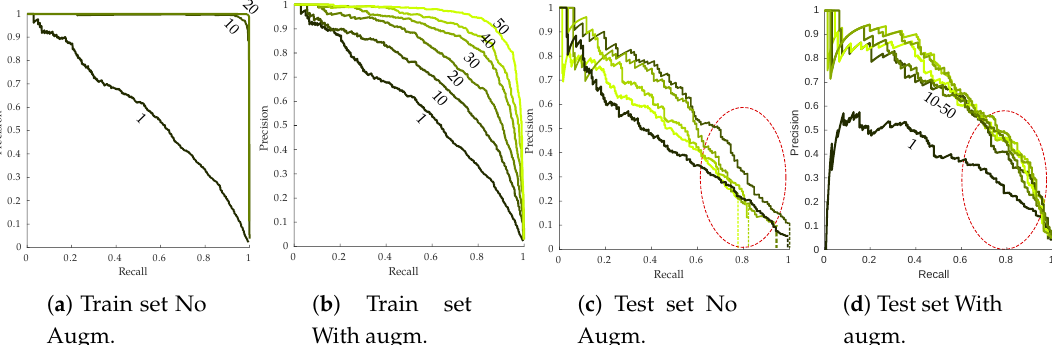
Figure 14. Effect of the data augmentation parameter on training ( a , b ) and testing ( c , d ) esca RP curves. Epochs 1/10/20/30/40/50 are plotted. Dark green curves: early epochs; light green curves, late epochs. Vertical dotted lines in ( c ) indicate the maximum achieved